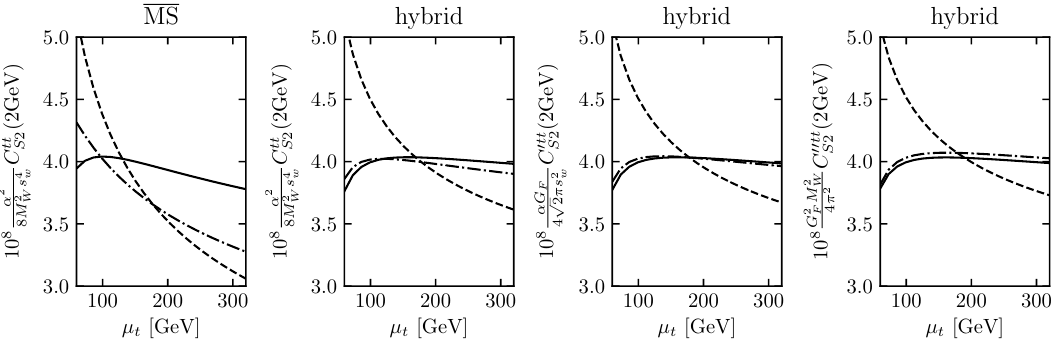
Figure 6 . Residual matching scale dependence with full QCD resummation, in the MS and hybrid schemes. The dashed line shows the LO result, the dash-dotted line shows the result including NLO QCD corrections, while the solid line show the full (QCD and QED) NLO result. See text for